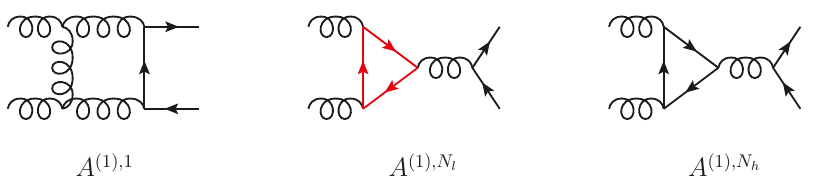
Figure 1. Sample Feynman diagrams corresponding to various internal flavour contributions at one loop as specified in eq. (2.3). Red lines, black spiral lines and black lines represent massless quarks, gluons and top quarks, respectively.